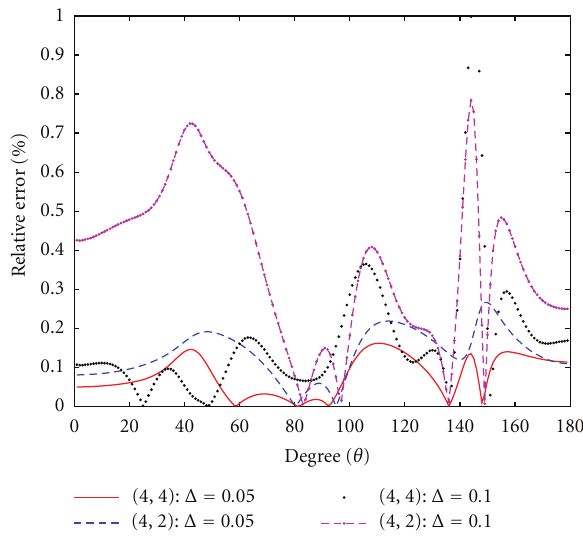
Figure 6: The relative error of computed E -plane RCS with di ff erent scheme at CFL = 0.6.